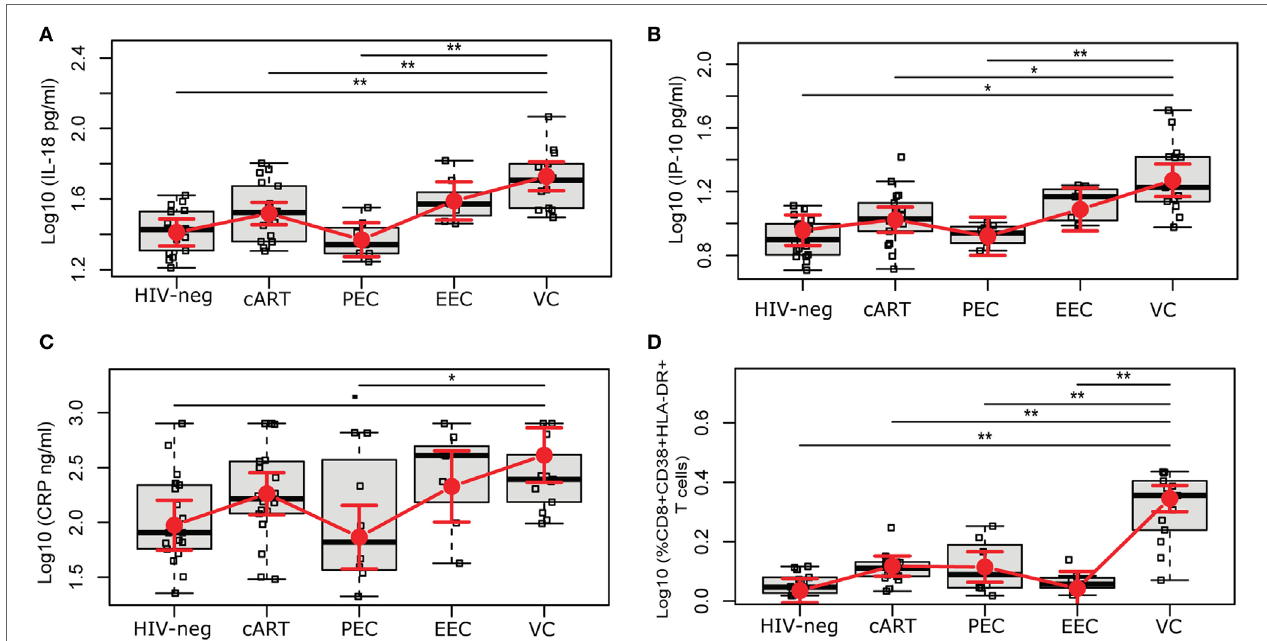
FigUre 1 | HIV-1 elite controllers have normal levels of inflammation and CD8 + T cell activation. HIV controllers were divided according to the level of viral controller: persistent elite controller, if 100% of VL measures were below the limit of detection; ebbing elite controller, if subjects had occasional ( < 30% of frequency) episodes of transient, low-level (51–400 copies/mL) viremia; and viremic controller, if most ( ≥ 70%) VL determinations were between 51 and 2,000 copies/mL. The plasmatic levels of (a) IL-18, (B) IP-10, and (c) CRP were measured by the ELISA test, and (D) the frequency of %CD8 + CD38 + HLA + DR + was evaluated by flow cytometry. The time point selected for this study is highlighted in Figure S1 in Supplementary Material. The results are expressed as Log10. Boxplots represent the IQR and sample median (central solid black line). Red dots and vertical bars represent linear model estimated adjusted means and 95% confidence intervals (CI 95%). Comparisons of means among groups were performed by contrasts/differences obtained after both bi- and multivariate-linear models fitted by ordinary least square regressions. P -values were corrected by the Tukey Honest Significant Difference post hoc method, and a Type I error adjustment was conducted for multiple comparisons following the Holm-Bonferroni method. * P < 0.05, ** P <